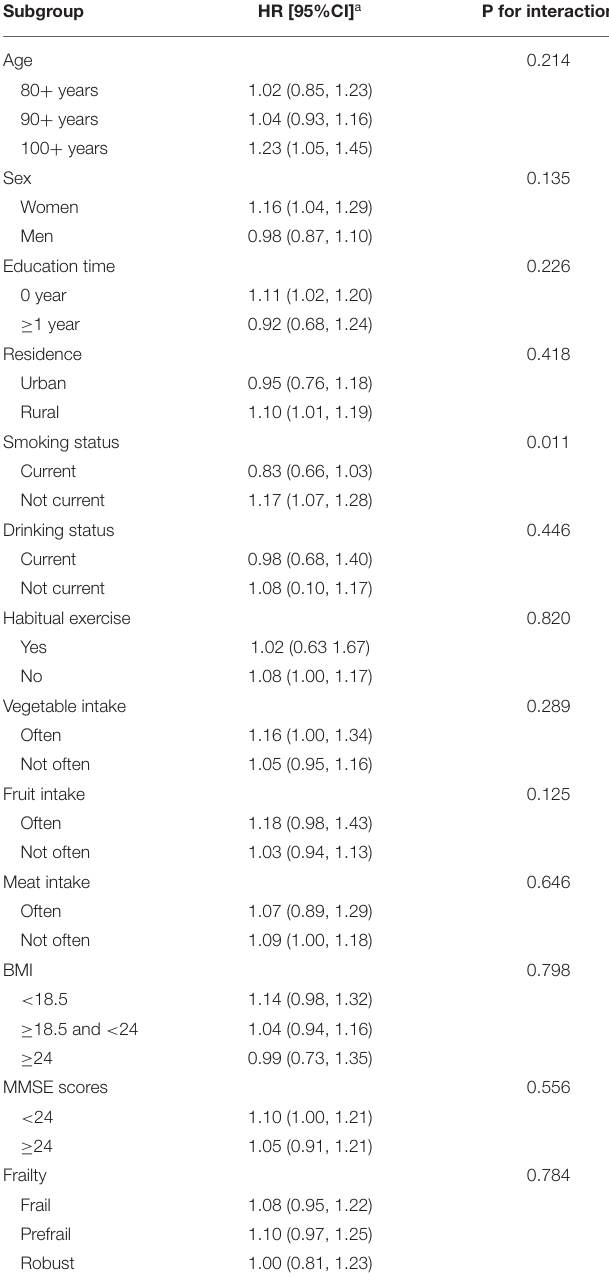
TABLE 3 | Subgroup analyses for the hazard ratio of all-cause mortality for each 10 mg/L increase in hsCRP.